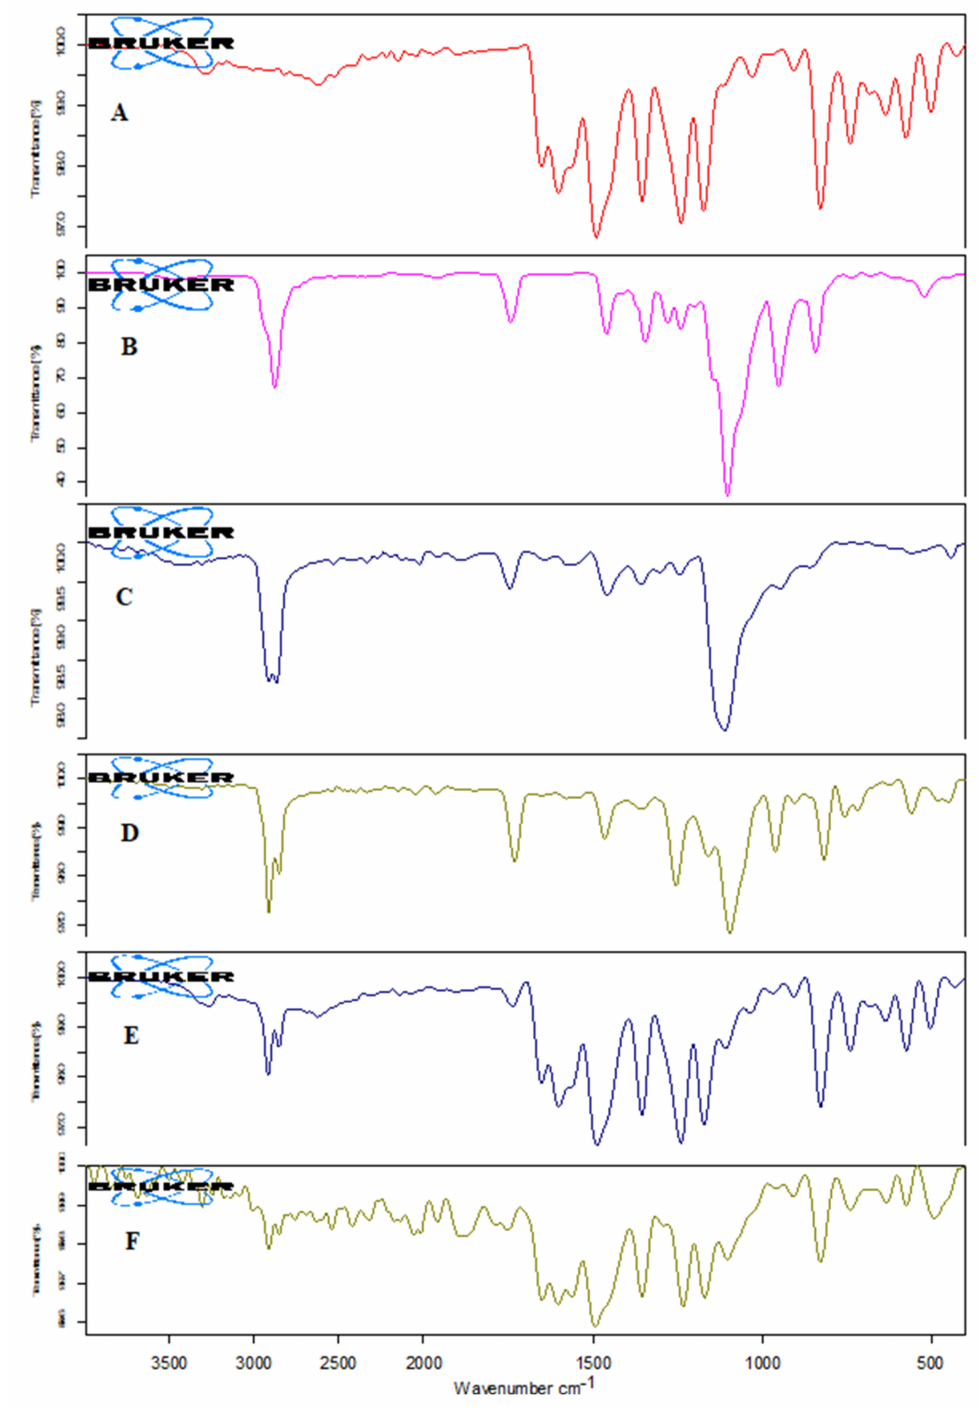
Figure 7. IR spectra of ( A ) Apigenin; ( B ) TPGS; ( C ) Chitosan; ( D ) Lecithin; ( E ) physical mixture; and ( F )